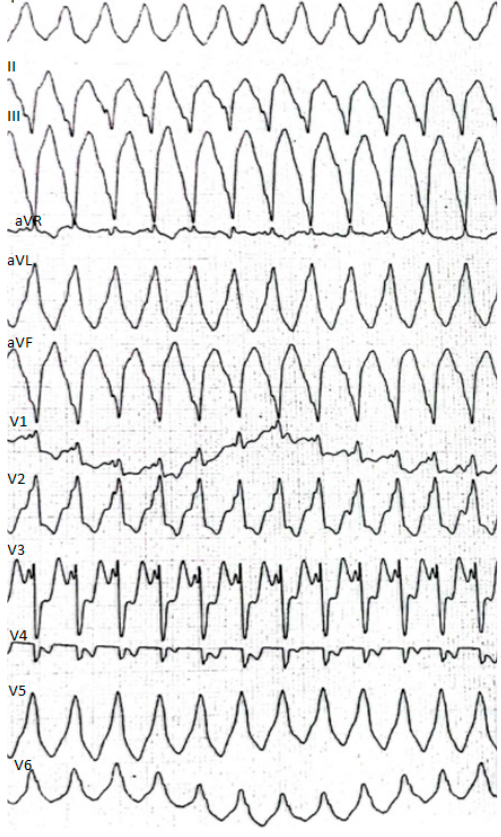
Figure 4. Resting electrocardiogram recording ventricular tachycardia at standard paper speed of 25 mm/s and normal calibration of 1 mV = 10 mm.